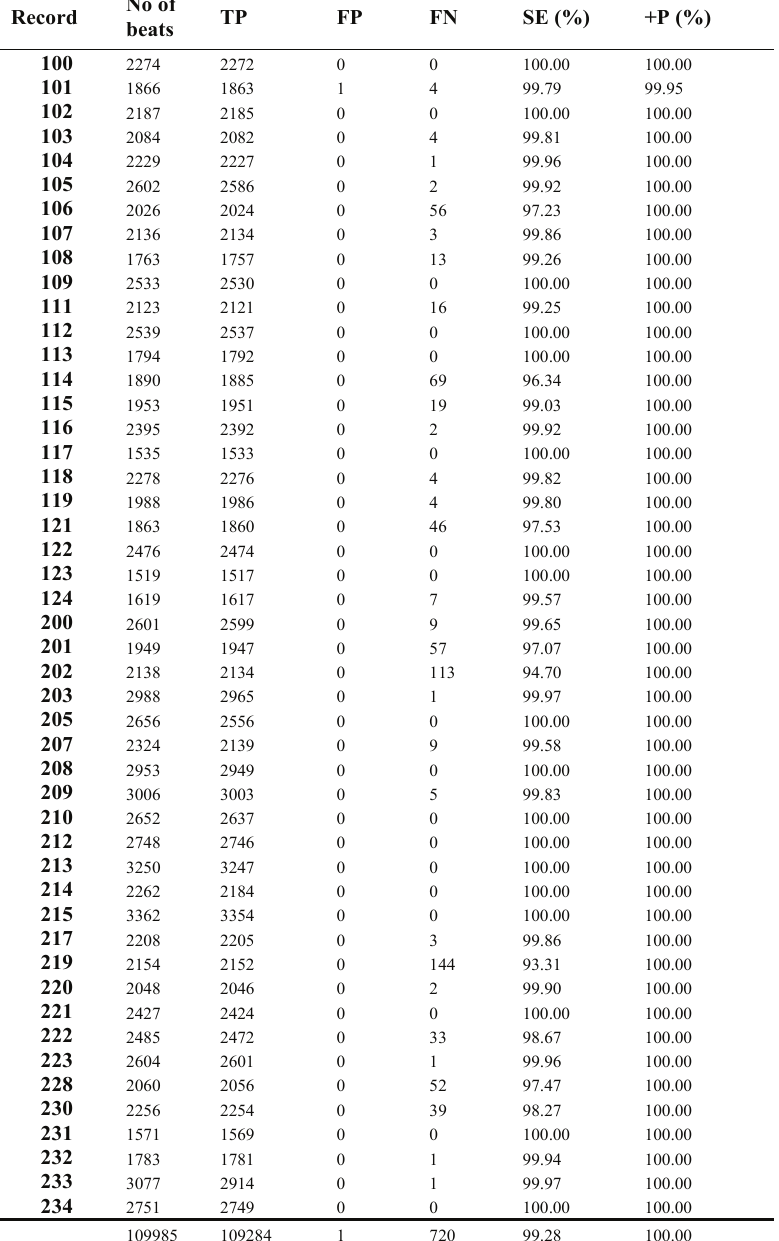
Table 1. T wave peak detection performance over the annotated MIT-BIH Arrhythmia database